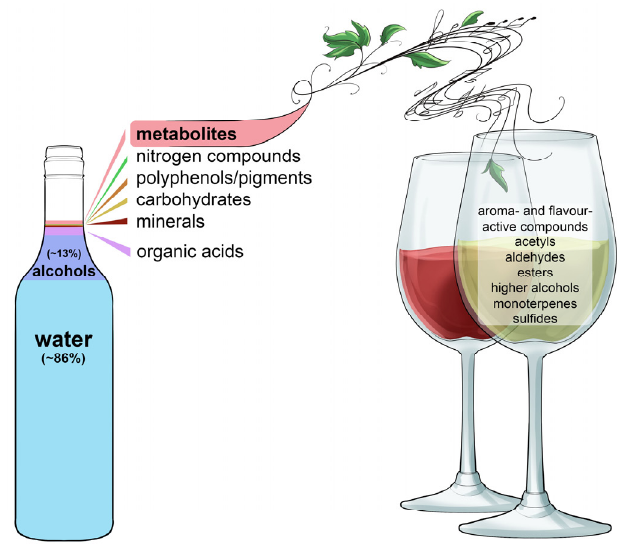
Figure 19. The chemical composition of wine. Wine consists of ca. 86% water, ca. 13% alcohols (mainly ethanol) and ca. 1% secondary metabolites. The latter contain the compounds that shape the aroma and flavour of wine.